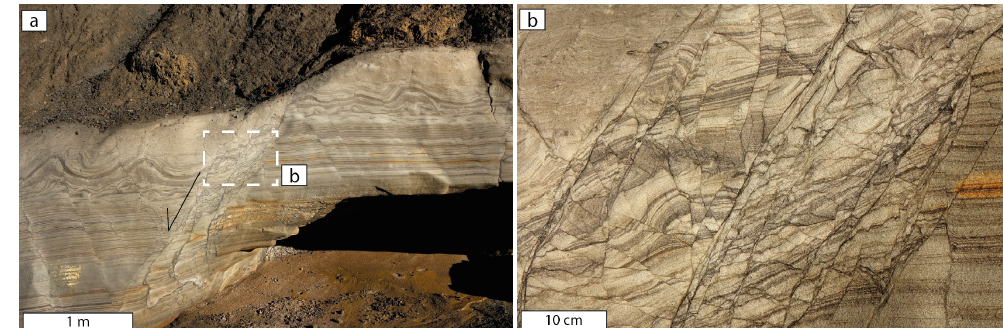
Figure 6. (a) Outcrop image of a normal fault hosted within a mudstone-rich sequence. The fault accommodates ca. 1m of displacement in the image plane. The displacement is distributed throughout multiple slip surfaces, narrow slip zones, and dense arrays of shear bands hosted within a high-strain zone. Adjacent to the high-strain zone are deformation bands and shear bands with similar and opposing dip. All structures accommodate normal-sense shear displacement. (b) The compactional shear bands accommodate displacement and can link to form a dominant slip surface. DBs have a darker colour compared with the host rock and recessive relief. Sedimentary layering is displaced with normal-sense shear offset. Within the high-strain zone, DBs dominantly share the same orientation as the fault displacement. However, bands with variable orientations are present indicating high strain within the